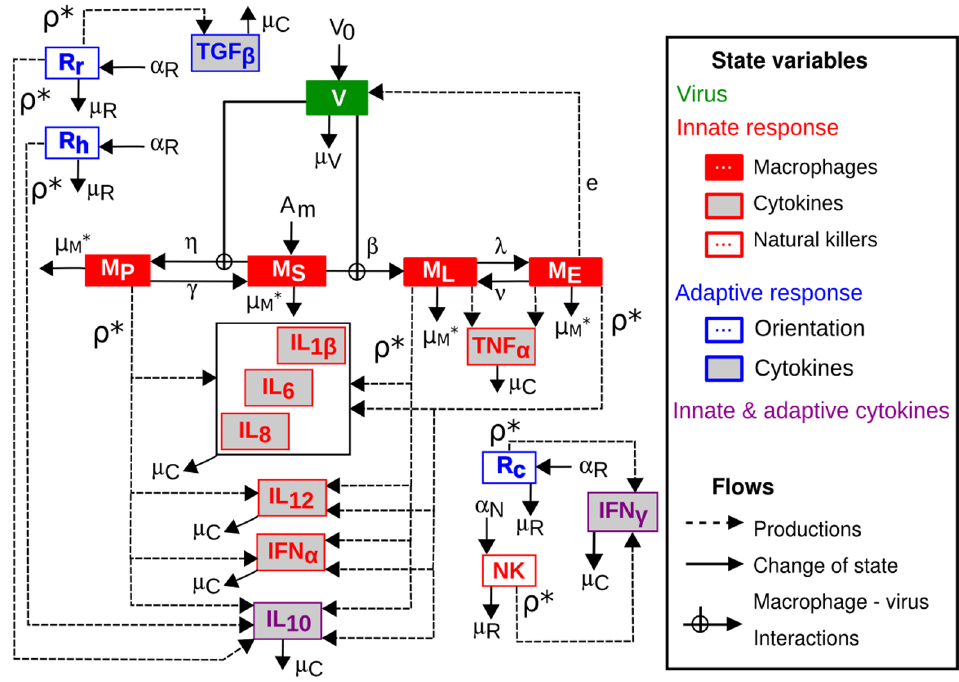
Figure 2. Conceptual model: state variables and flows without regulations. The state variables consist of: the free viral particles ( V ); the susceptible ( M S ), phagocyting ( M P ), latent ( M L ) and excreting ( M E ) macrophages; the natural killers ( NK ); the cellular ( R c ), humoral ( R h ) and regulatory ( R r ) adaptive cells; the pro-inflammatory cytokines ( IL 1 b , IL 6 & IL 8 ; grouped in the box), the innate antiviral cytokines ( IFN a & TNF a ) and the immuno-regulatory cytokines ( IL 12 , IFN c , IL 10 & TGF b ). The flows represented are: the inoculation of free viral particles ( V 0 ); the recruitment of susceptible macrophages ( A m ); the activation of natural killers ( a N ) and cells of the adaptive response ( a R ); the decay of the free viral particles ( m v ), the macrophages ( m M *), the natural killers ( m N ), the adaptive cells ( m R ) and the cytokines ( m C ); the macrophage state changes, i.e. phagocytosis ( g and c ), infection ( b ) and transient excretion ( l and n ); the excretion of free viral particles by infected macrophages ( e ) and the cytokine syntheses by activated immune cells ( r *). For the sake of readability, the cytokine and cell regulations and not drawn and some parameter notations (marked with *) are